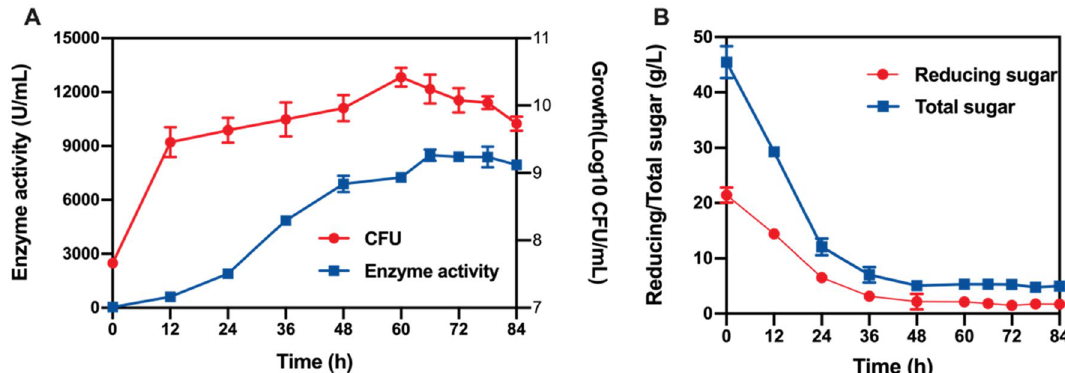
Fig. 1 The process of alkaline protease production using the initial fermentation medium